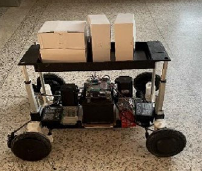
Figure 10. High load test.